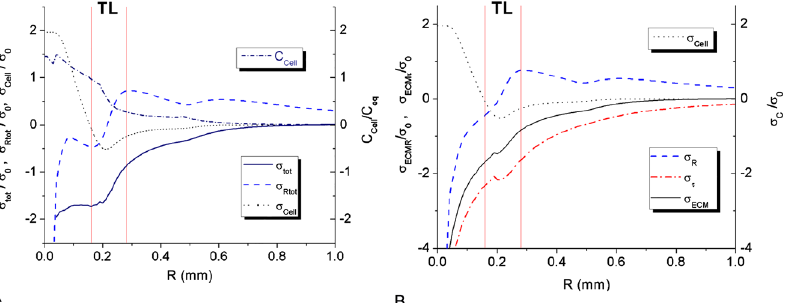
Figure 6: Stress distribution along MTS radius at day 3. (A) The total stress distribution σ tot / σ 0 is calculated within iso-strain model;thegraphalso showsradialcomponentof thetotal stress σ Rtot / σ 0 ,the stressconditioned bycells interaction σ Cell / P 0 and concentrationofcells C cell / C eq , σ 0 =100Ps;(B)distributionofECMstress σ ECM / σ 0 ,tangentialcomponentof ECMstress σ τ / σ 0 and its radial component σ R / σ 0